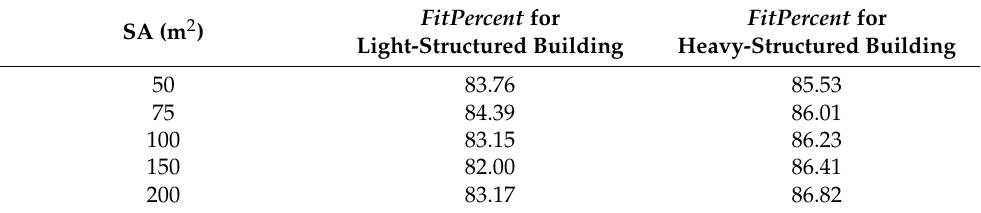
Figure 7. Comparison between the estimated indoor temperature of 4R3C model and TRNSYS simulation results for 100-2-15-0 building (first 1000 h of TMY). Table 8. FitPercent calculations for heavy- and light-structured buildings with various SA values (x-2-15-0). (Evaluated for the first 1000 h of TMY).